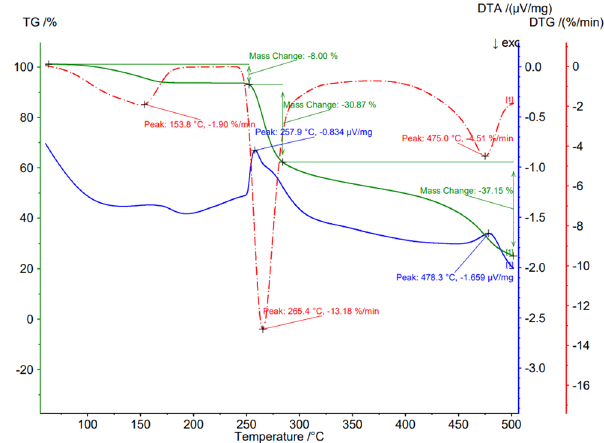
Figure 2. DTA and TG analysis of acyclovir.